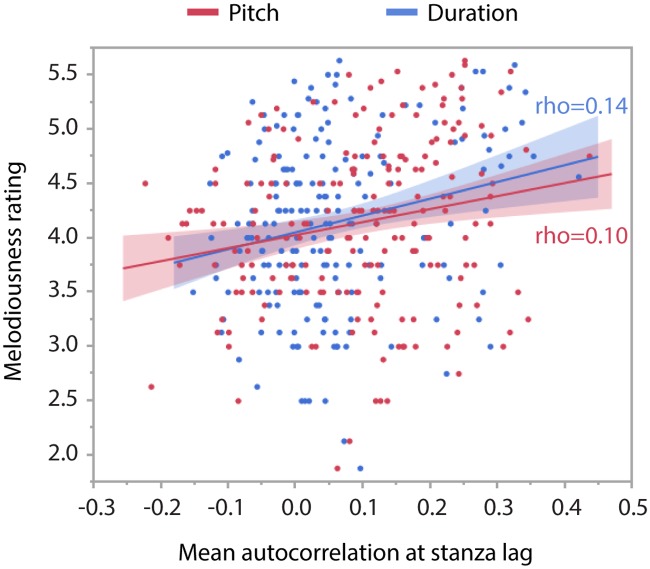
Overall correlations between melodiousness ratings and mean autocorrelations at stanza lag, plotted separately for pitch-based autocorrelations (red) and duration-based autocorrelations (blue).These correlations involve all poem versions.